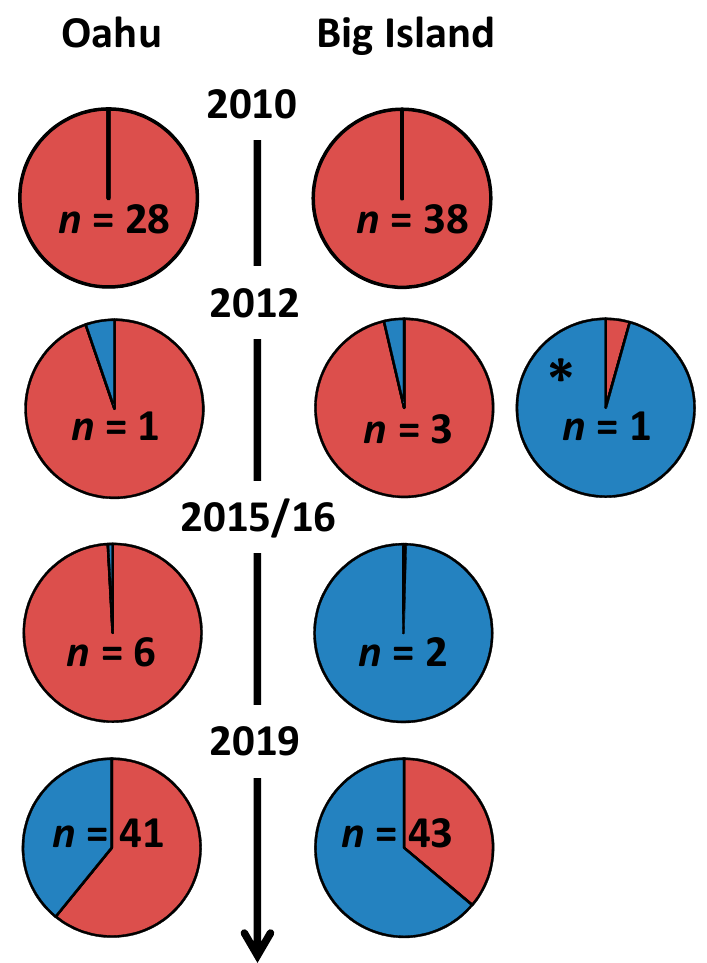
Figure 3. Changing proportions of DWV-A (red) and DWV-B (blue) on Big Island and Oahu over time. Sample sizes of the studies are given within the pie charts. Data for 2010 is from [9], 2012 [29], 2012 * [17], 2015/16 [26] and 2019 (this study). 2012 and 2012 * could not be combined due to the different methodologies used. N.B. Pie chart sizes do not convey DWV genome equivalents.